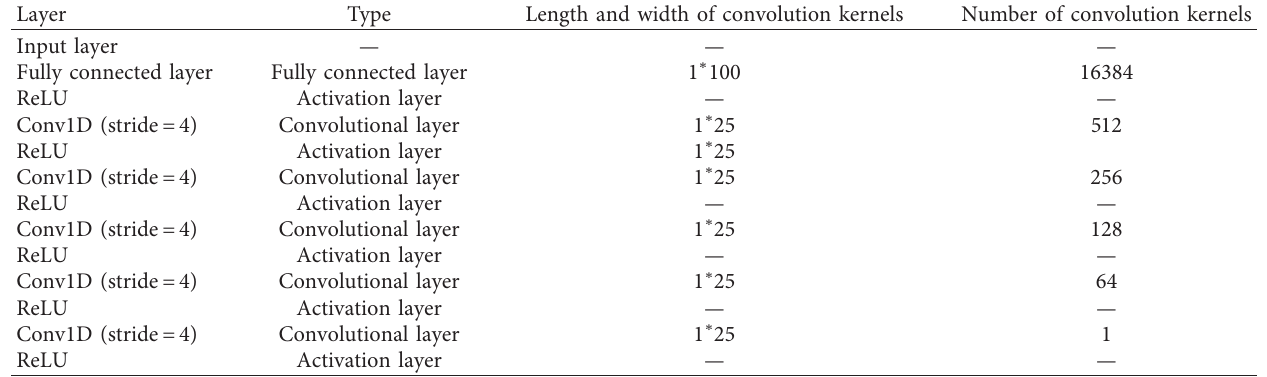
Table 1: Generator structure of the raw audio GAN model.